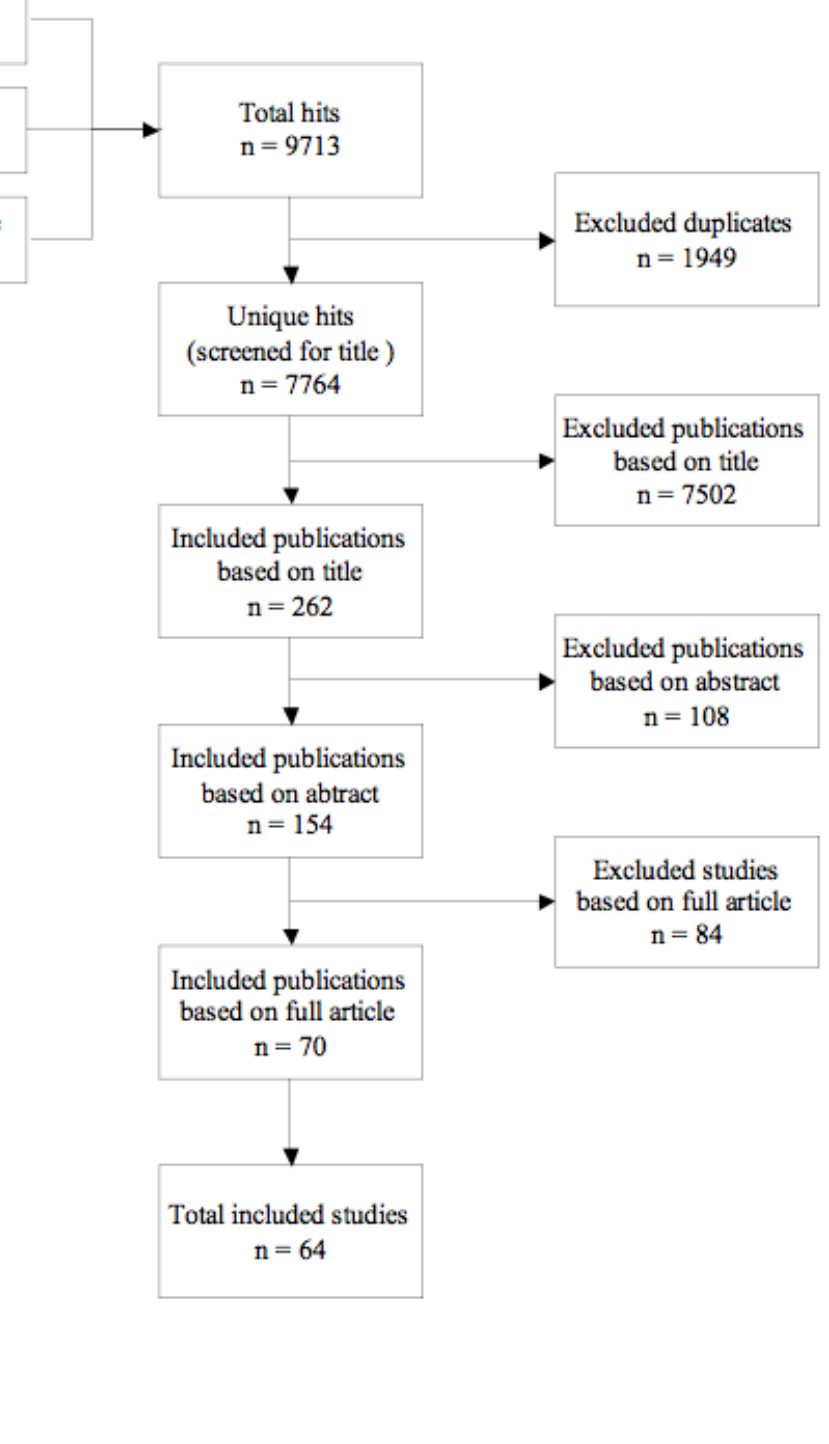
Figure 1. Flow chart review